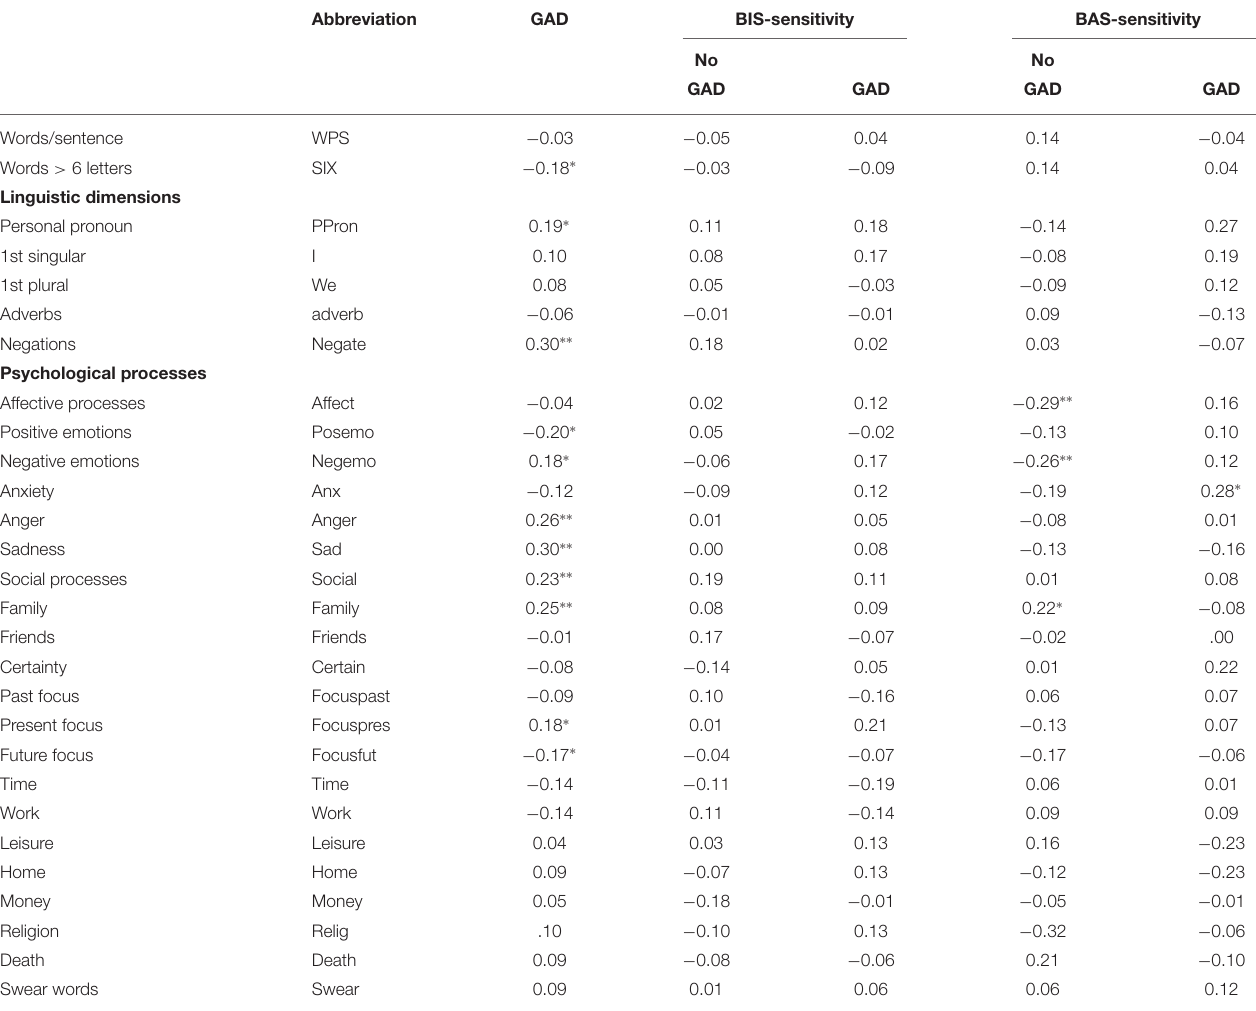
TABLE 2 | Language Inventory Word Count (LIWC) and Behavioral Inhibition System (BIS ) and Behavioral Approach System (BAS) correlations for Generalized Anxiety Disorder (GAD) (* p < 0.05 level, ** p < 0.01 level; two-tailed). Abbreviation GAD BIS-sensitivity